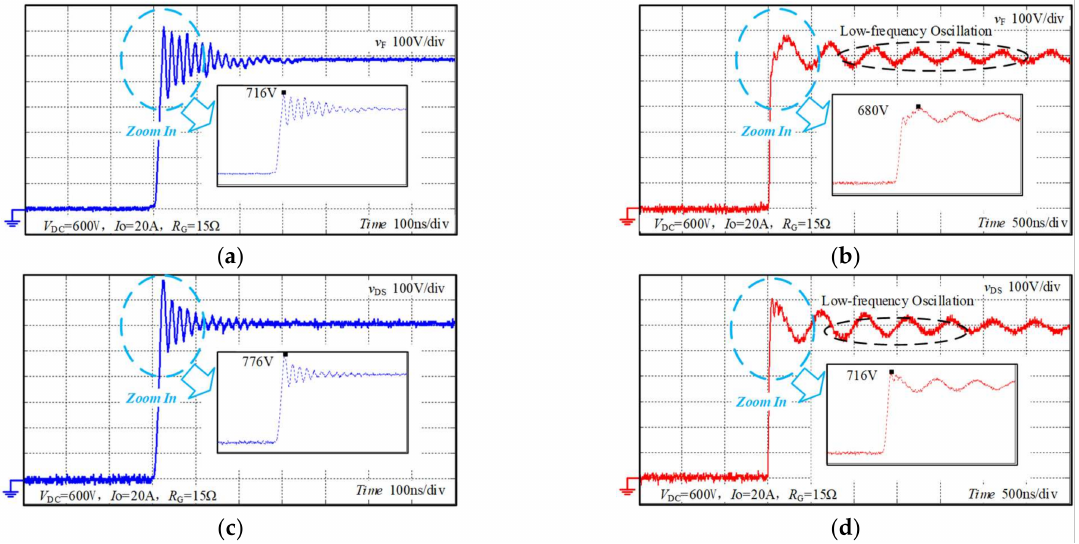
Figure 10. Tested waveforms without and with capacitor C DE . ( a ) Turn-off voltage of the SiC diode without C DE , ( b ) turn-off voltage of the SiC diode with C DE = 100 nF, ( c ) turn-off voltage of the SiC MOSFET without C DE , and ( d ) turn-off voltage of the SiC MOSFET with C DE = 100 nF.